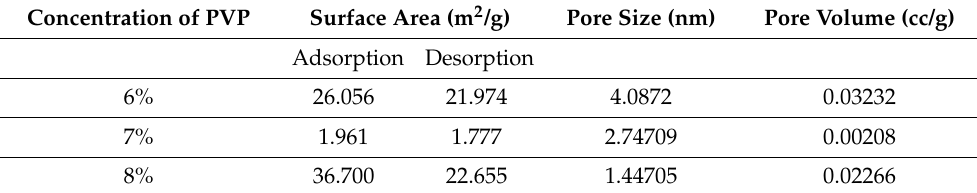
Figure 7. Adsorption-Desorption Curve 8% PVP.